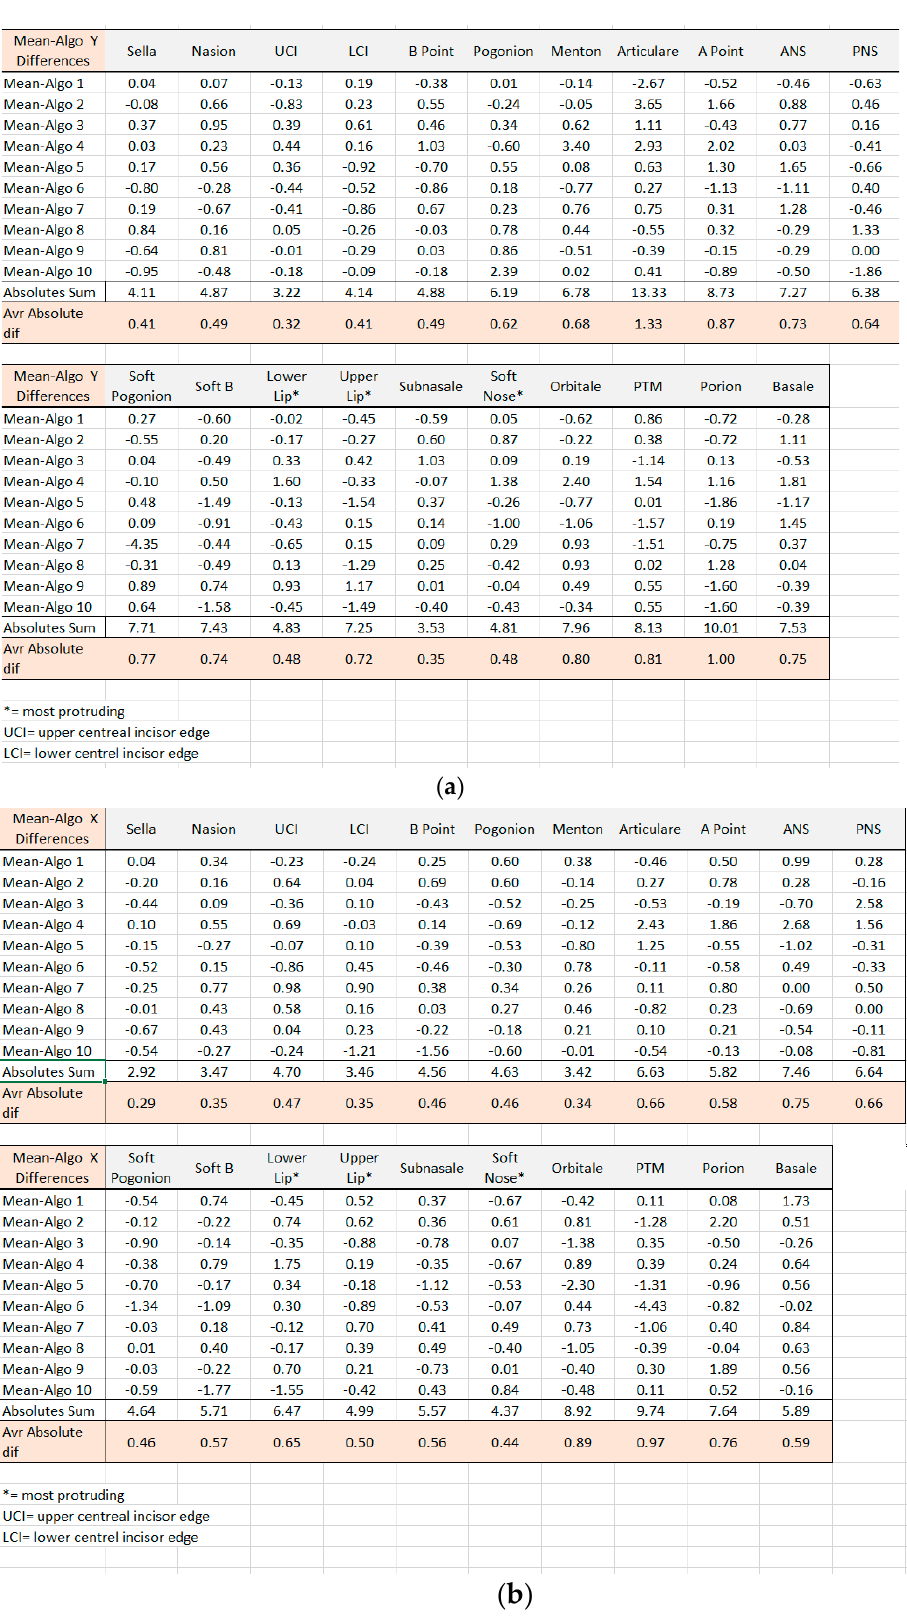
Figure 6. ( a ) Differences between the Algoceph and observer mean for the 21 landmarks of 10 different cephalograms in the vertical y plane. ( b ) Differences between the Algoceph and the and observer mean for the 21 landmarks of 10 different cephalograms in the horizontal x plane.